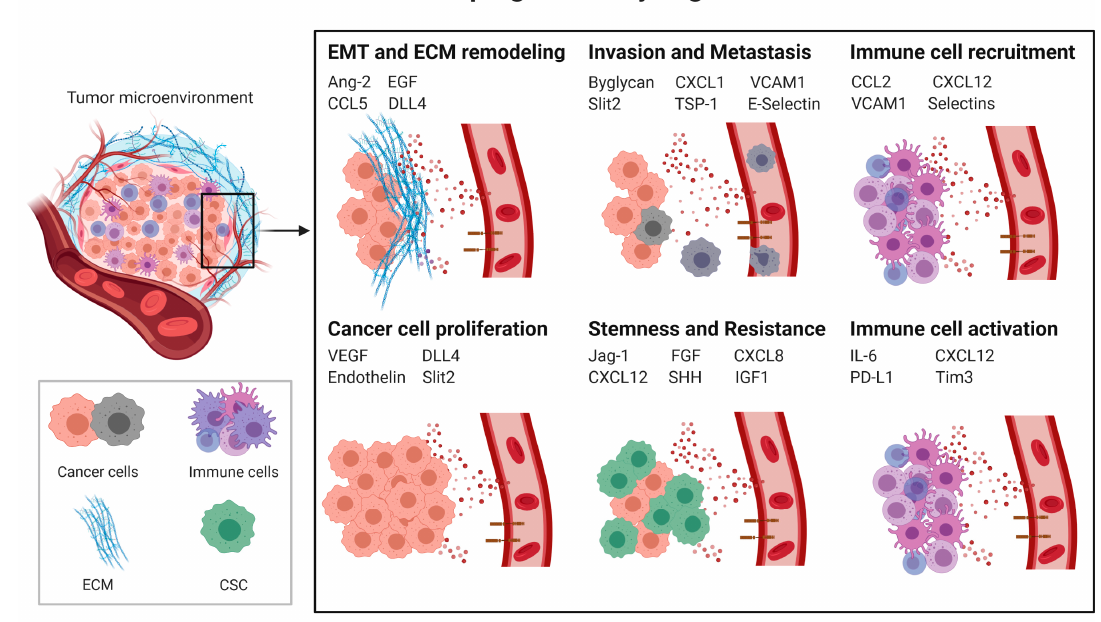
Figure 1. Control of tumor progression by angiocrine factors; CSC: cancer stem cells; EMT: Epithelial to mesenchymal transition; ECM: Extracellular matrix; Ang2: Angiopoietin-2, CCL2: C-C Motif Chemokine Ligand 2, CCL5: CC-chemokine ligand 5, CXCL1: C-X-C Motif Chemokine Ligand 1, CXCL8: C-X-C Motif Chemokine Ligand 8, CXCL12: C-X-C Motif Chemokine Ligand 12, DLL4: Delta-like 4, EGF: Epidermal Growth Factor, FGF: Fibroblast Growth Factor, ICAM1: Intercellular Adhesion Molecule 1, IGF1: Insulin-like growth factor 1, IL6: Interleukin-6, PD-L1: Programmed death-ligand 1, Shh: Sonic Hedgehog, Tim-3: T-cell immunoglobulin and mucin-domain containing-3, TSP-1: Thrombospondine-1, VEGF: Vascular endothelial growth factor, VCAM1: Vascular cell adhesion protein 1.